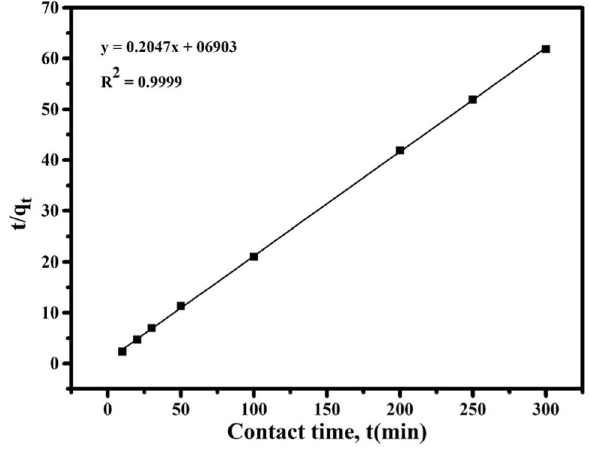
Fig. 12 Pseudo-second-order kinetic model for the adsorption of MB dye on the PBF